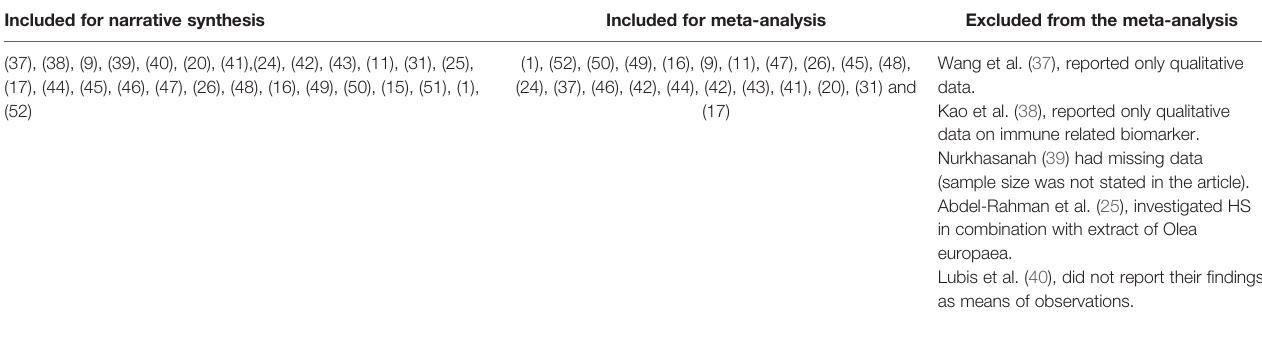
TABLE 1 | Summary of included and excluded